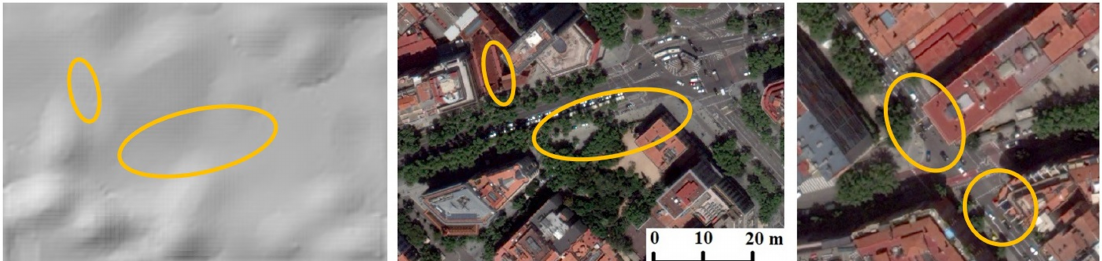
Figure A4. DTM (left image) and DTM-based orthophoto (center and right images).